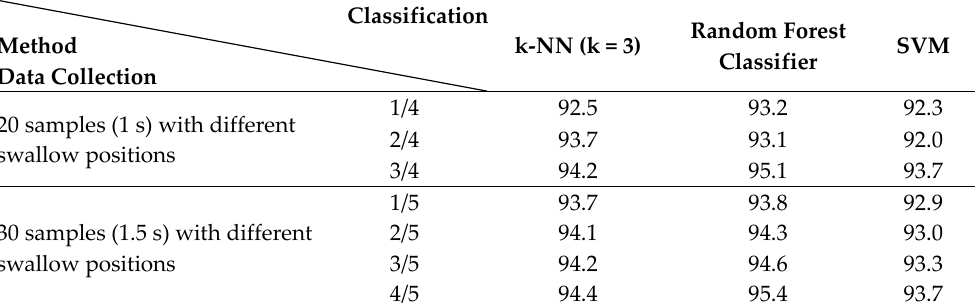
Table 2. Classifier performance with 20- and 30-sample windows.